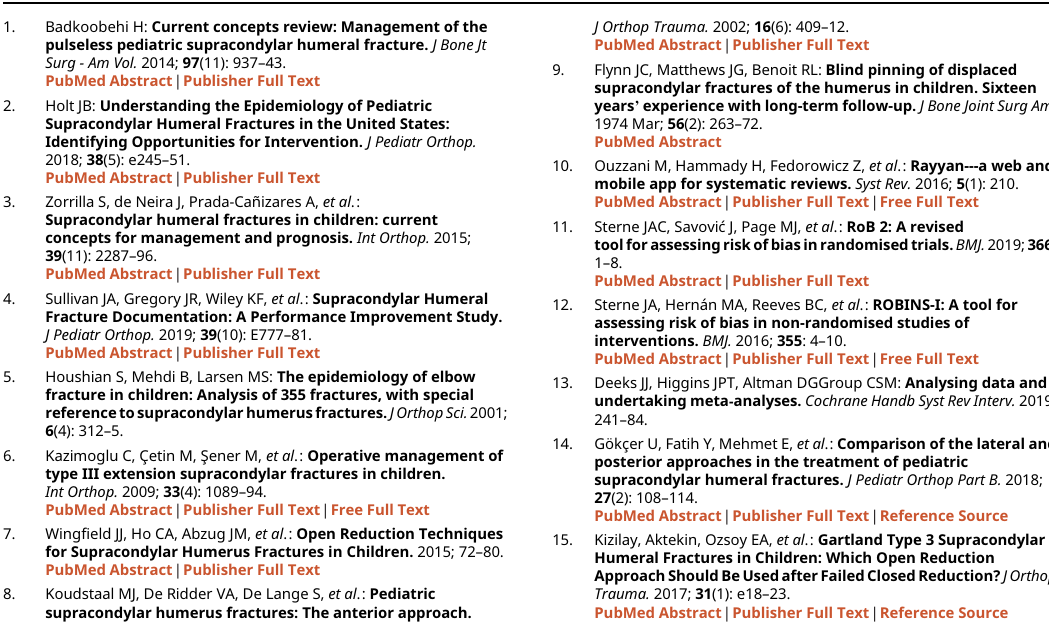
Figshare: Appendix 1 search strategy. https://doi.org/10.6084/m9.figshare.14740584.v1. 30 Data are available under the terms of the Creative Commons Attribution 4.0 International license (CC-BY